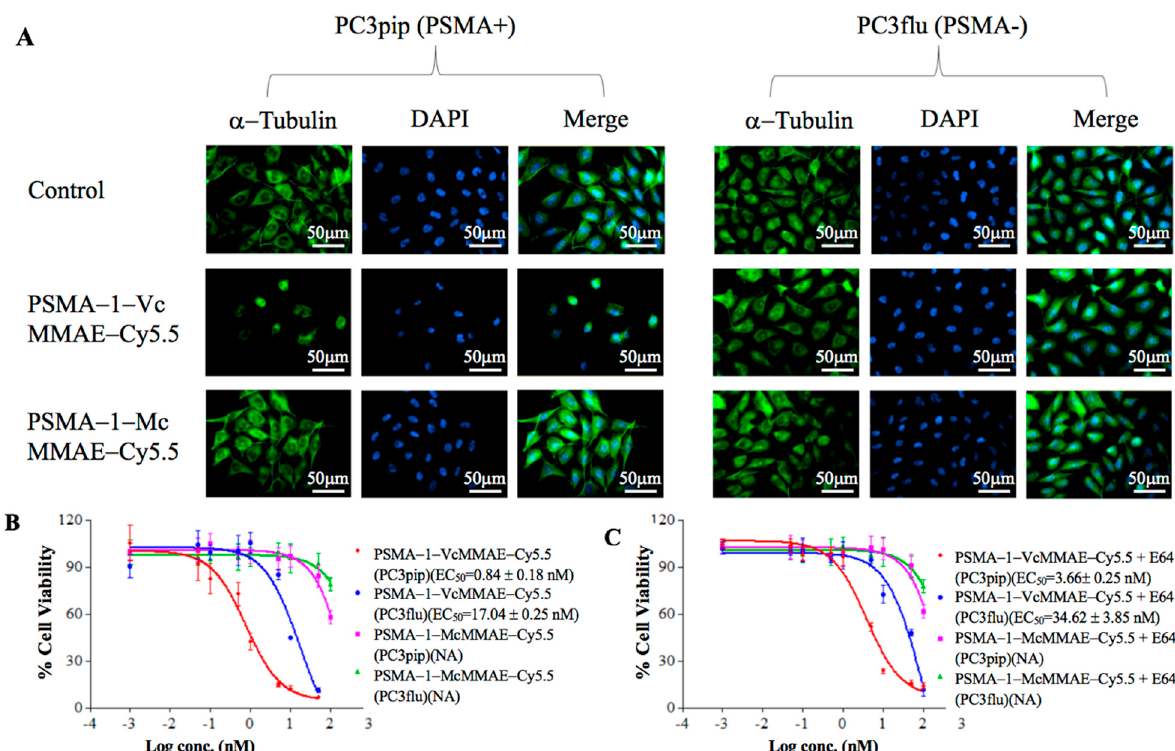
Figure 3. In vitro disruption of α -tubulin and cytotoxicities of PSMA-1-MMAE-Cy5.5 conjugates. ( A ) Immuno-detection of α -tubulin. Cells were treated with 5 nM of drugs for 24 h then fixed and stained by Alexa Fluor 488-labeled α -tubulin antibody (false color green). Selective disruption in PC3pip cells was observed by immunofluorescence only when cells were treated with PSMA-1-VcMMAE-Cy5.5. Images were taken at 40X. Representative images are shown from three independent experiments. ( B ) In vitro cytotoxicity of PSMA-1-VcMMAE-Cy5.5 and PSMA-1-McMMAE-Cy5.5 to PSMA-positive PC3pip cells and PSMA-negative PC3flu cells after 72-h incubation. Values are mean ± SD of six replicates. ( C ) In vitro cytotoxicity of PSMA-1-VcMMAE-Cy5.5 and PSMA-1-McMMAE-Cy5.5 to PC3pip and PC3flu cells after 72-h incubation in the presence of E64, a protease inhibitor. Values are mean ± SD of six replicates.